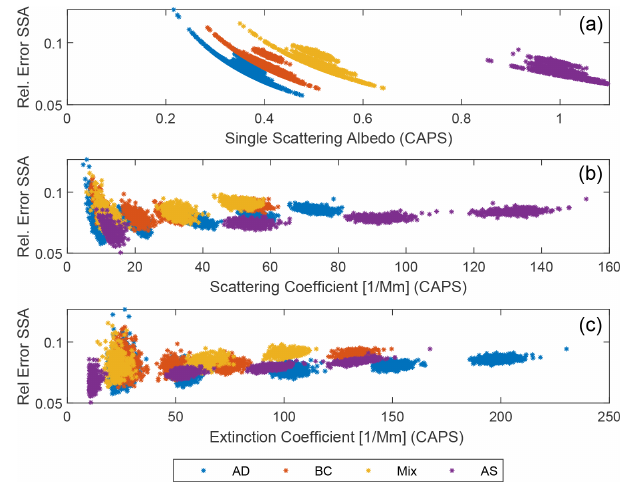
Figure A1. Relative error in the single-scattering albedo (SSA) derived from CAPS measurements as a function of the derived SSA (a) , σ sp (b) and the extinction coefficient (c)